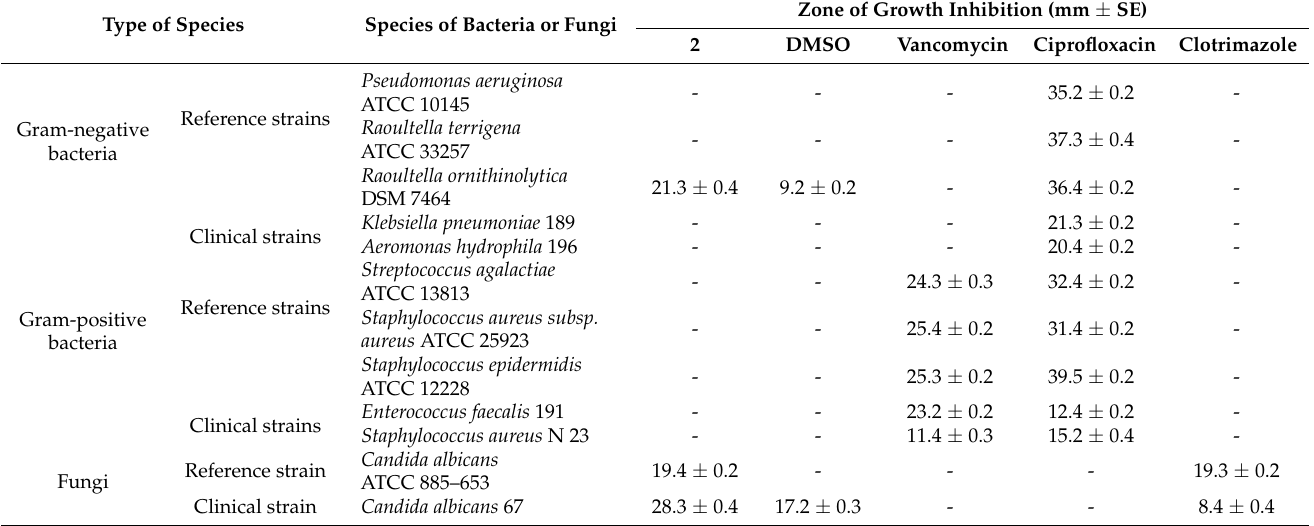
Table 1. In vitro antimicrobial activity of compound 2 (zone of growth inhibition at conc. 1 mg/mL after 24–48 h).